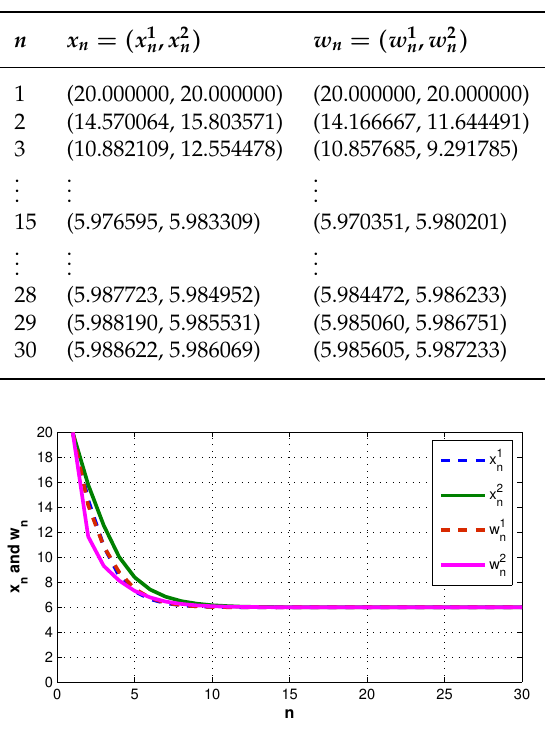
Figure 1. The convergence of { x n } and { w n } with initial values x 1 = ( 20,20 ) , w 1 = ( 20,20 ) and n = N =